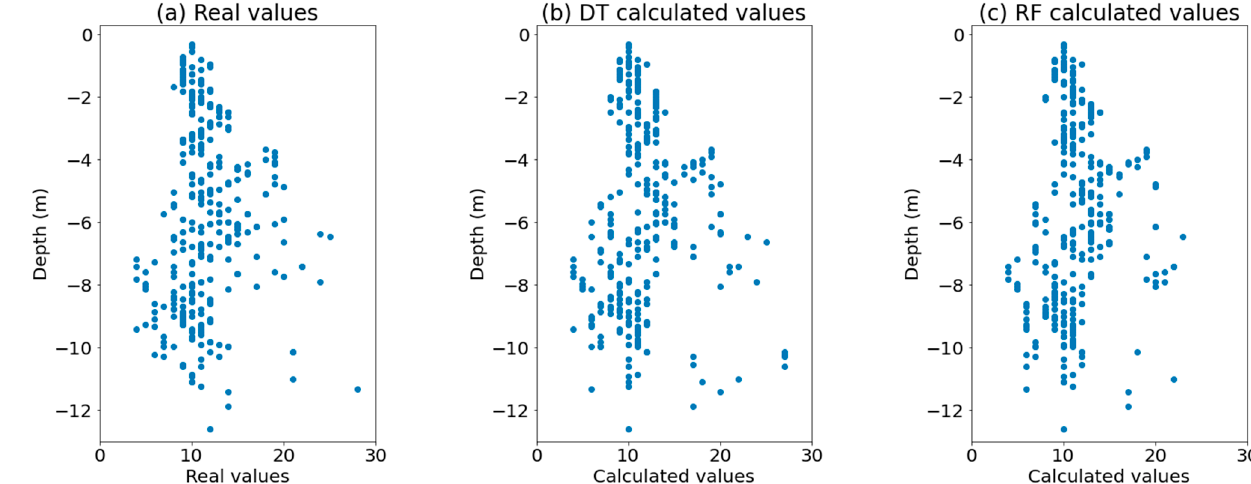
Figure 16. Real and calculated values for site 2 considering depth. ( a ) Real values. ( b ) Values calcu- lated by DT. ( c ) Values calculated using RF.